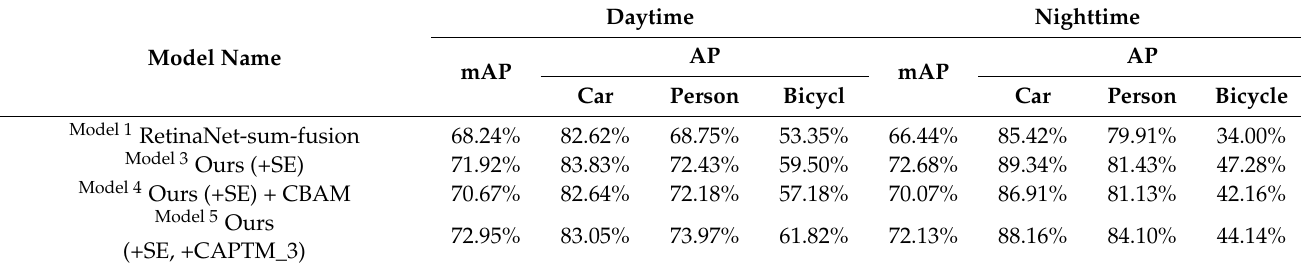
Table 7. Detection accuracy comparisons in daytime and nighttime